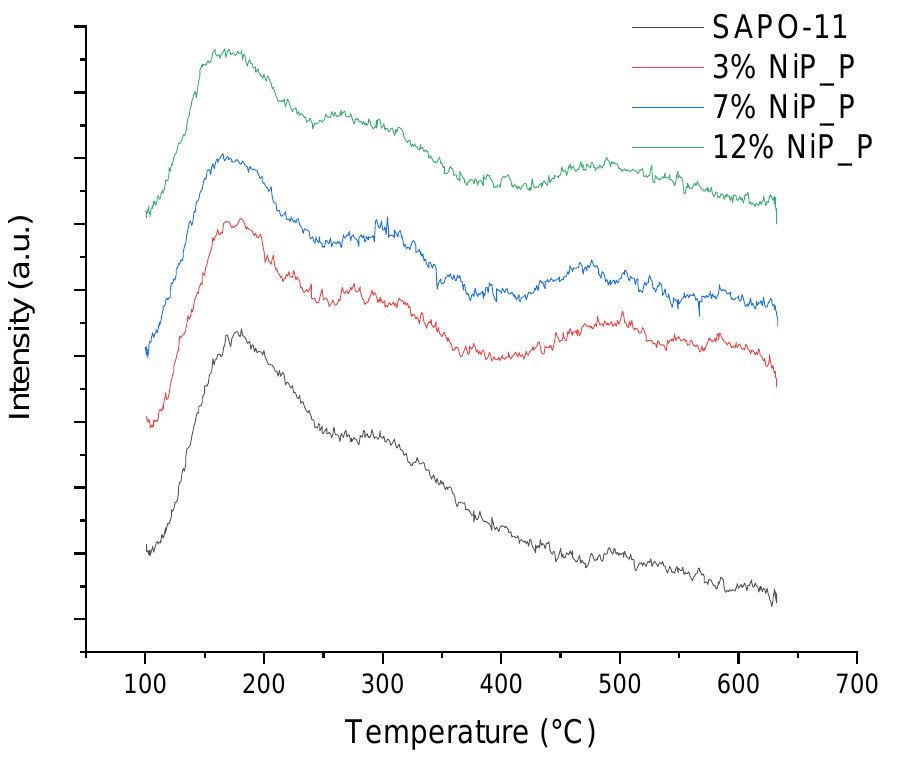
Figure 9. NH 3 -TPD of SAPO-11 and the NiP_P samples.